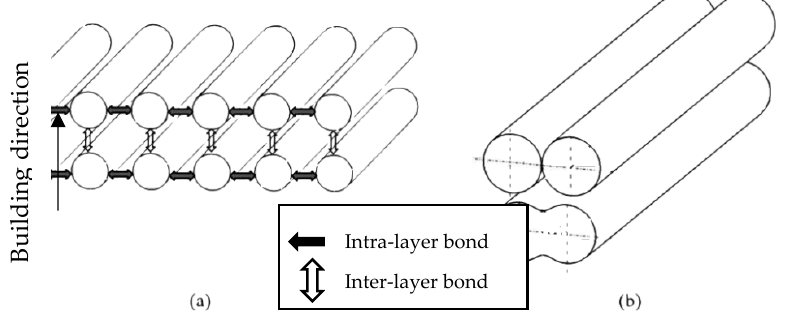
Figure 4. ( a ) Inter-layer and intra-layer bonding in FDM, ( b ) stages of bond formation in FDM. Reprinted with permission from [23], 2014, Taylor and Francis, Abingdon, UK.